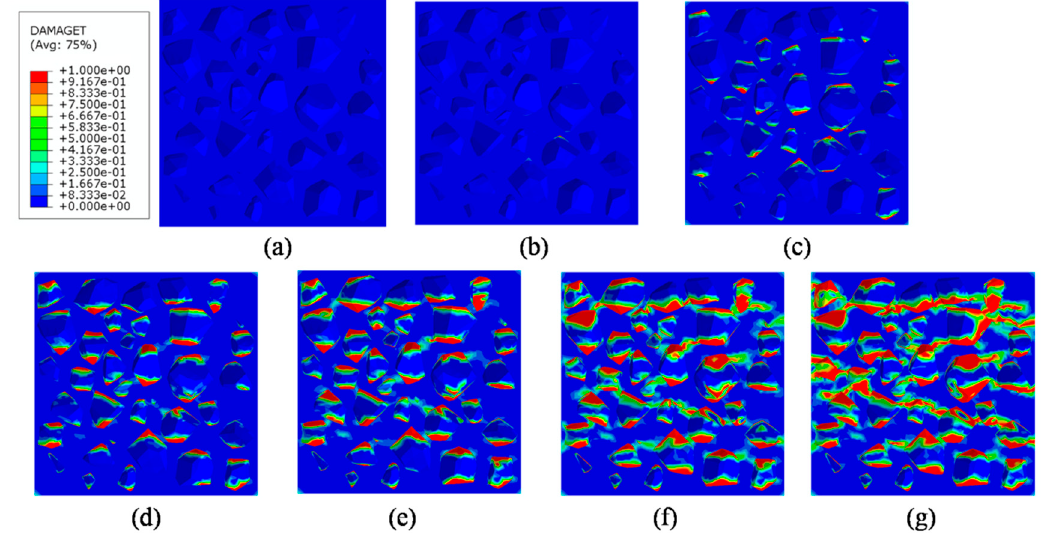
Figure 33. Section patterns of tensile damage initiation and evolution under tension.